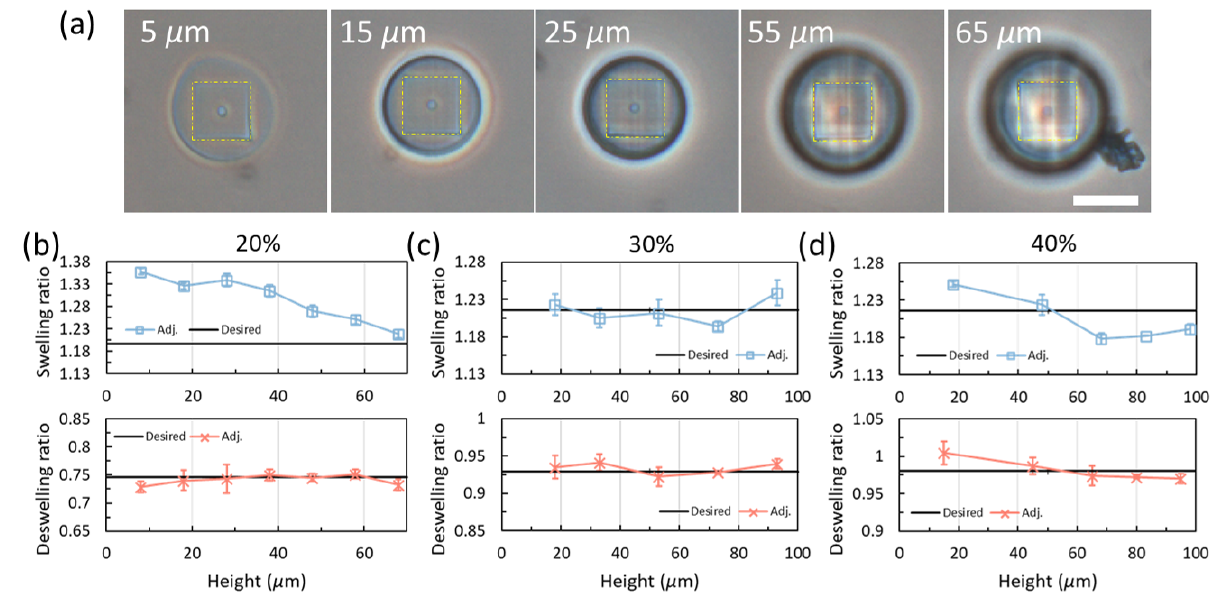
Figure 8. Deswelling and swelling tests with the adjusted fittings. ( a ) Samples printed with the adjusted curve for 20% with different heights. The yellow dash rectangles with an identical size mark out the sizes of the characterization layers. Scale bar: 25 µ m. ( b – d ) Deswelling and swelling ratios of the samples printed with the adjusted curves in water and alkaline solution, respectively. ( b ) 20%. ( c ) 30%. ( d )